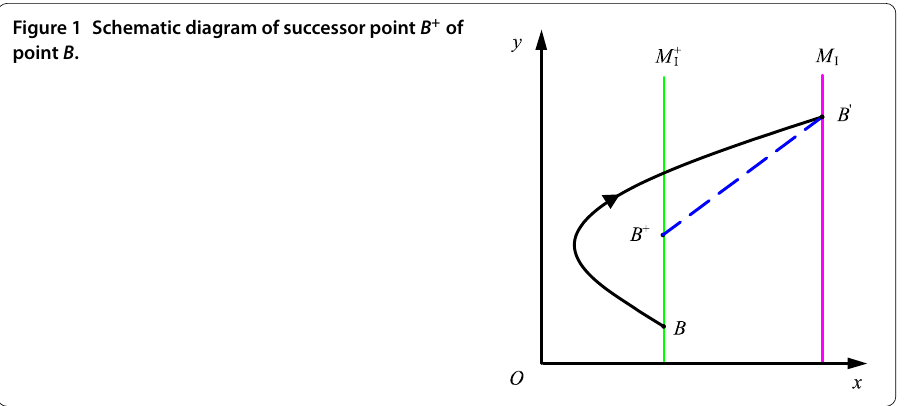
Figure 1 Schematic diagram of successor point B + of point B